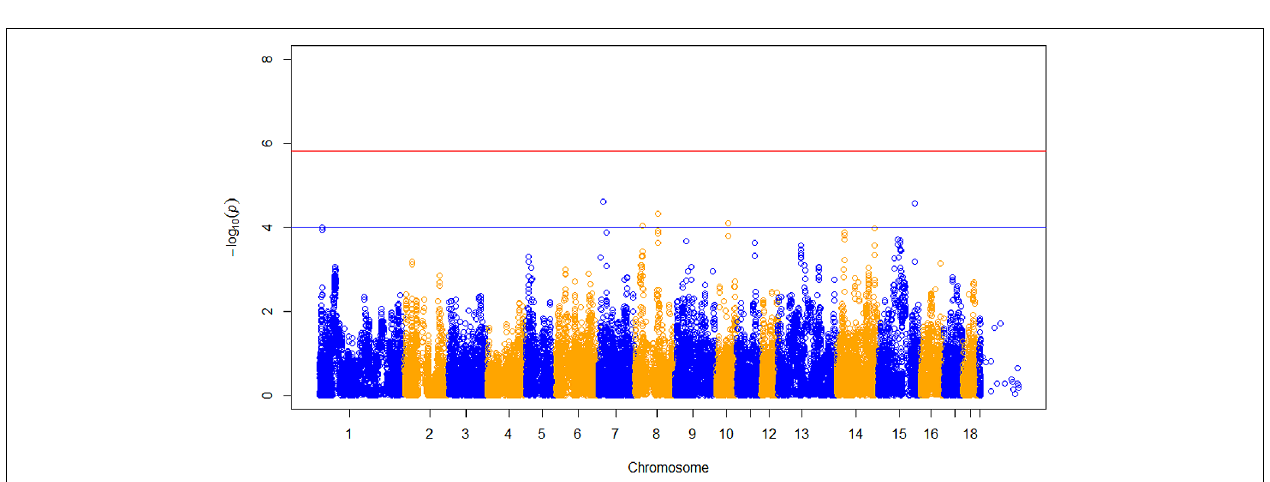
FIGURE 1 | Manhattan plot of genome-wide p of association for residual feed intake 1 (RFI). The horizontal red and blue line represents the Bonferroni ( p = 1.31e − 06) and genome-wide significance threshold ( p ≤ 1e − 04), respectively.